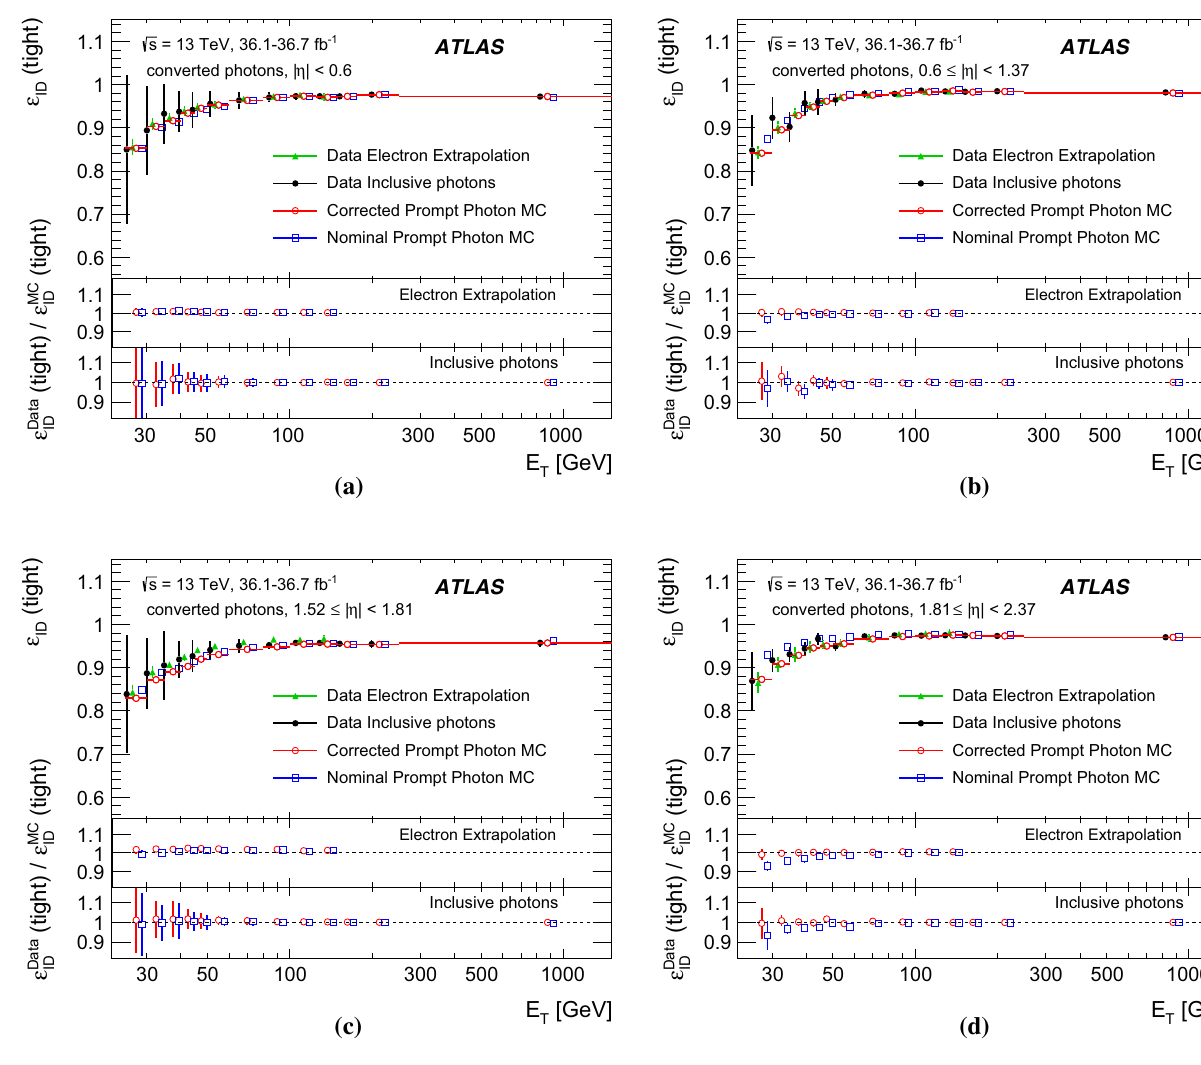
Fig. 12 Comparisonofthemeasurementsofthedata-drivenidentifica- tionefficiencyforconvertedphotonsobtainedusingtheelectronextrap- olationandinclusivephotonmethodswiththepredictionsfromprompt- photon+jet simulation as a function of photon E T , for the four pseudo- rapidity intervals a | η | < 0 . 6, b 0 . 6 ≤ | η | < 1 . 37, c 1 . 52 ≤ | η | < 1 . 81,